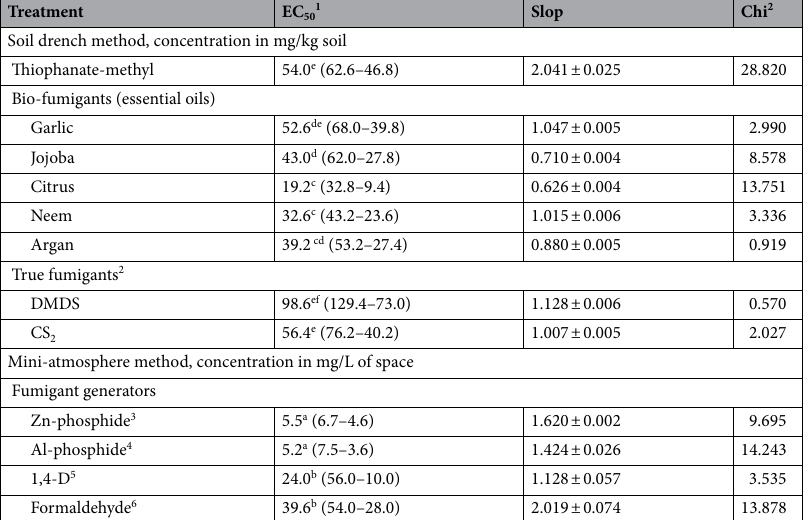
4 Al-phosphide 3 .